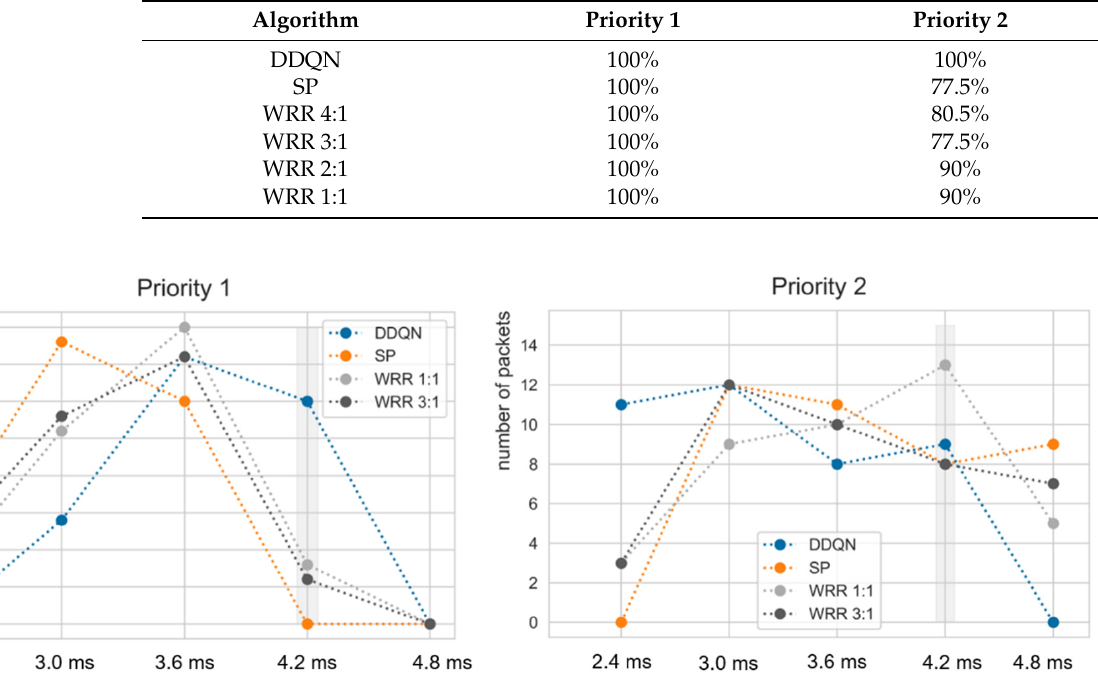
Figure 9. ET of the DDQN, SP, and WRR scheduler in the single node environment. The gray area denotes the deadline of priority 1 and priority 2 flows. The total packet number of each priority is